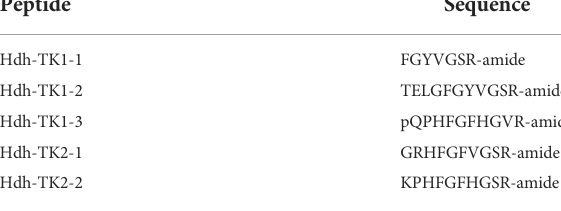
TABLE 2 Synthesized Hdh-TK peptide sequences.